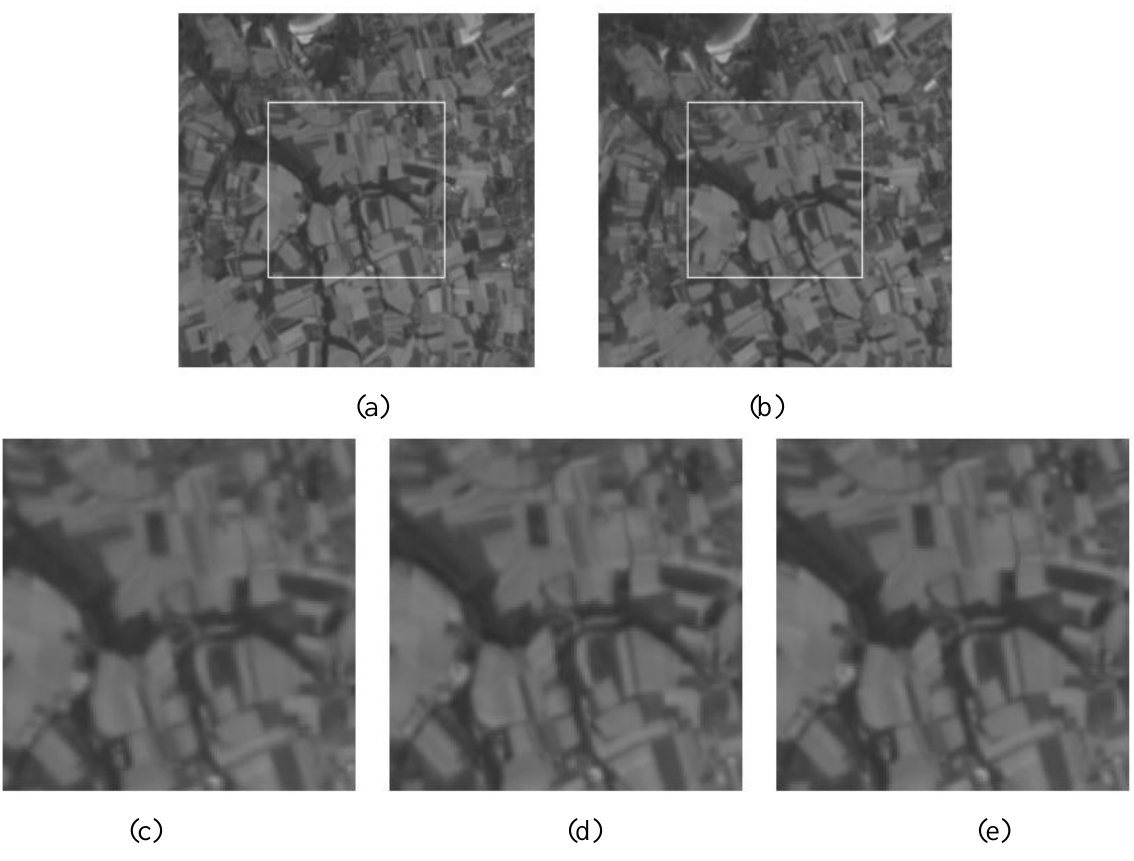
Figure 7. Registration of SPOT images using the three methods: (a) reference image, (b) transformed image to be corrected, (c) registered image using wavelet, (d) registered image using the first proposed method, and (e) the corrected image using the second proposed